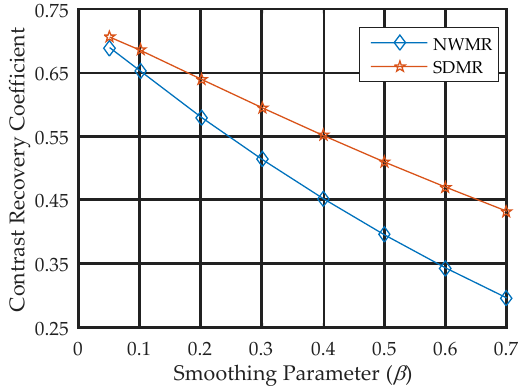
Figure 10. Regional MCRC curves evaluated over a range of the smoothing parameter β for NWMR and SDMR.